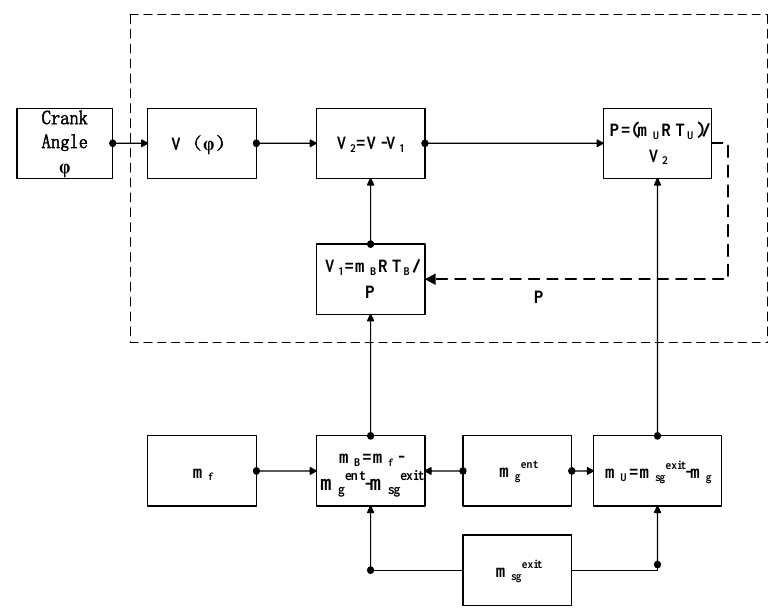
Figure 3. Flow chart of volume calculation for the two-zone model.